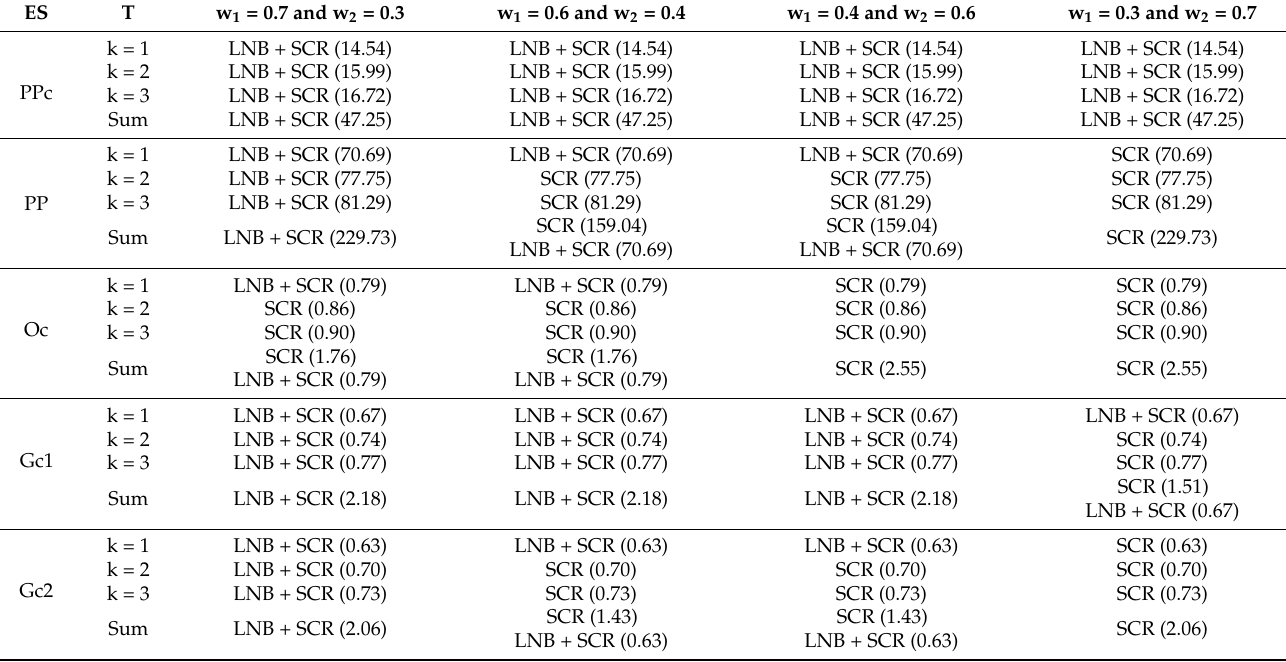
Table 6. The optimal treated NO X magnitude of various